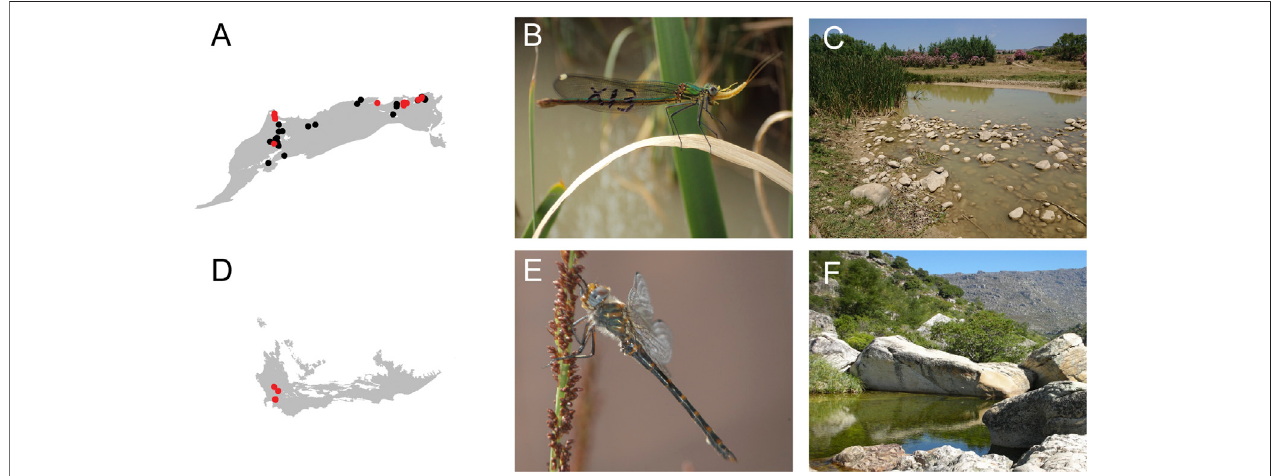
FIGURE7 | Distributionand habitat characteristics ofa North and aSouth Africanendemic odonate. (A) Geographic distribution of Calopteryxexul in North Africa. (B) Female adult C. exul eating a may fl y. (C) Typical habitat of C. exul . The picture indicates the habitat of the species in a dry year (2018) where the fl oating leaves for oviposition become rare due to drought. (D) Geographic distribution of one of the world ’ s rarest dragon fl ies, Syncordulia serendipator . (E) S. serendipator male. (F) Typical habitat of S. serendipator . The species lives in a few open deposition pools high in the Cape Fold mountains, and highly susceptible to further climate change as it has nowhere else to go. Red and black points indicate extant and uncertain occurrence, respectively.